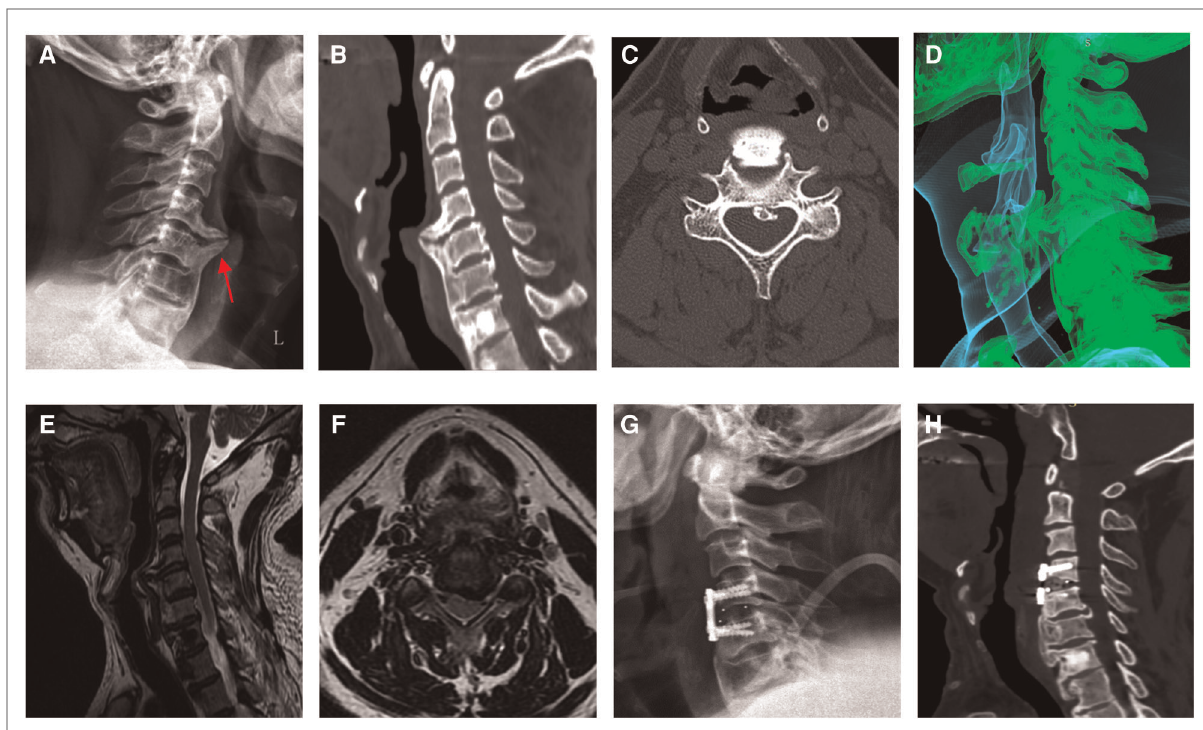
FIGURE 2 ( A ) osteophyte formation can be seen in front of the C4 – C7 vertebral body on cervical radiographs before operation, and a giant coracoid osteophyte can be seen at the anterior edge of C4 – C5. ( B,C ) The C4 – C5 segment showed the formation of a huge osteophyte in the anterior margin and ossi fi cation of the posterior longitudinal ligament in the spinal canal. ( D ) Preoperative three-dimensional computed tomography (CT) reconstruction showing that hyperplastic osteophytes compressed the trachea and esophagus. ( E,F ) Preoperative magnetic resonance imaging showing that the spinal canal space became narrower at the C4 – C5 level. ( G,H ) Radiographic and CT examination after operation showed that the large osteophyte in front of the C4-C5 vertebral body had been removed.